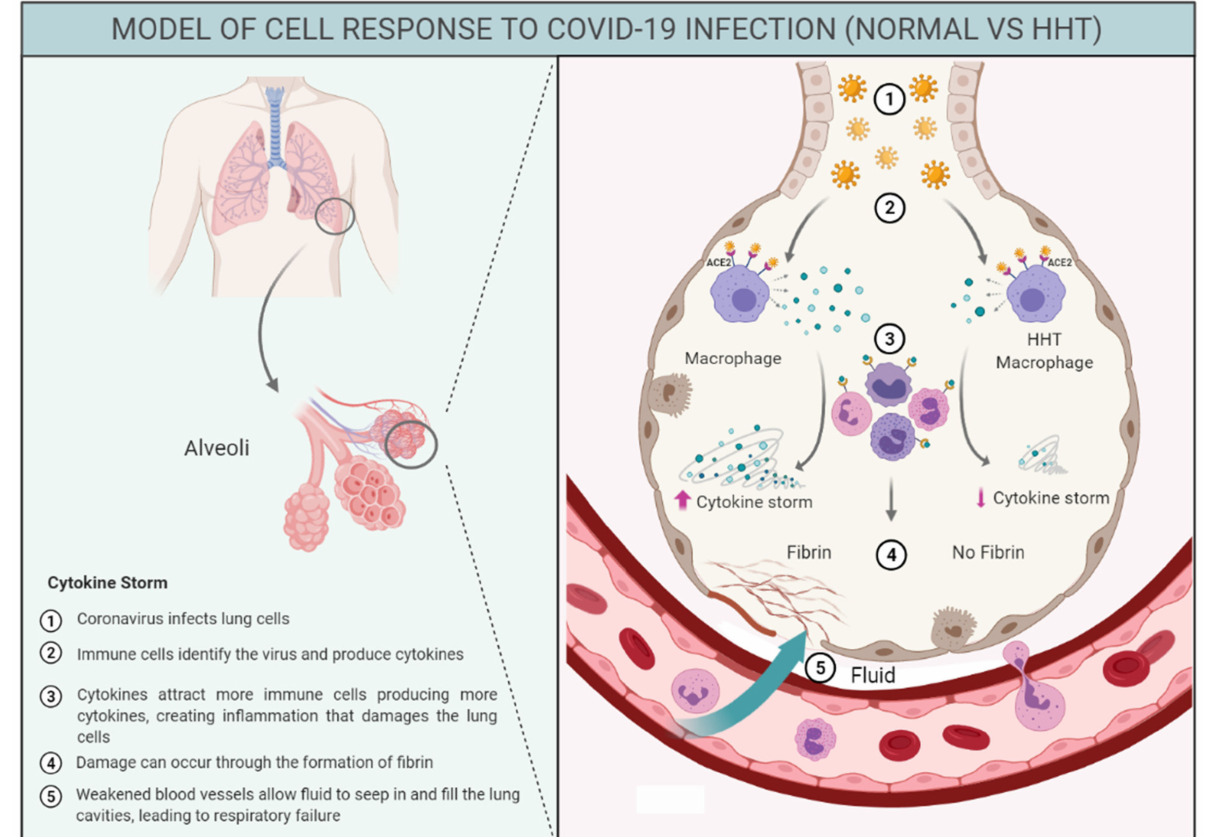
Figure 3. Graphical scheme explaining the COVID-19 reaction in HHT macrophages compared to macrophages of general population. The figure is based on the hypothesis that the cytokine production in HHT is not as exacerbated as the frequently occurred in the normal population leading to the “so-called” cytokine storm. 1. Coronavirus infects lung cells; 2. Immune cells, includes macrophages, identify the virus and produce cytokines; 3. Cytokines attract more immune cells, such as white blood cells, which in turn produce more cytokines, creating a cycle of inflammation that damages the lung cells; 4. Damage can occur through the formation of fibrin; 5. Weakened blood vessels allow fluid to seep in and fill the lung cavities, leading to respiratory